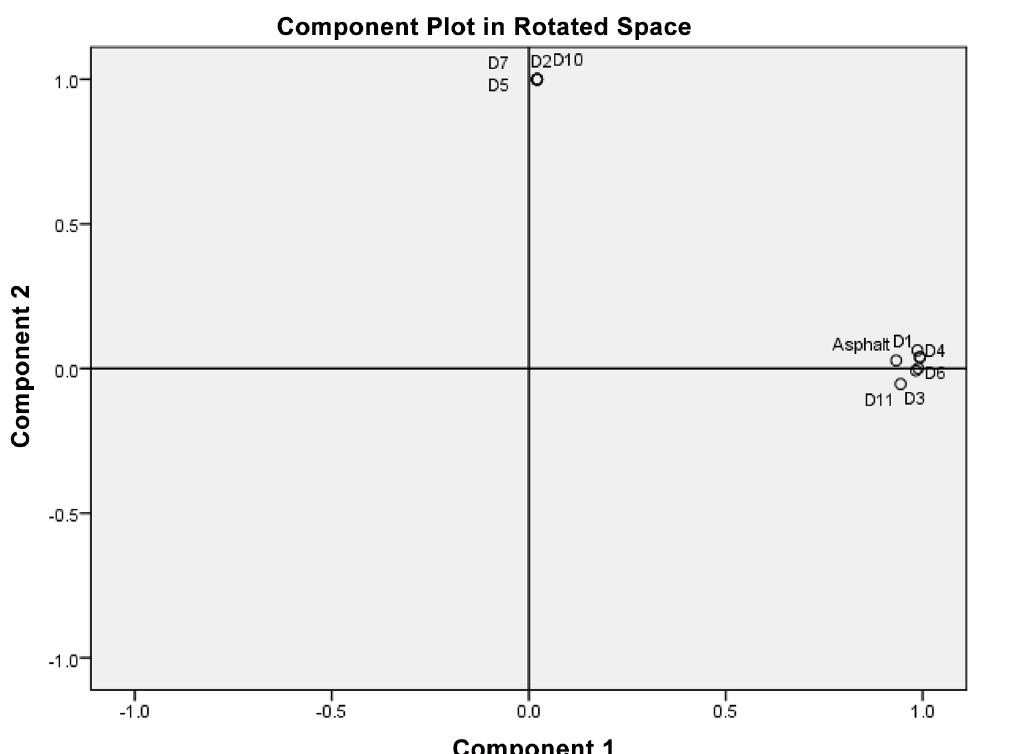
Fig 6. Plot showing the statistical output of principal component analysis